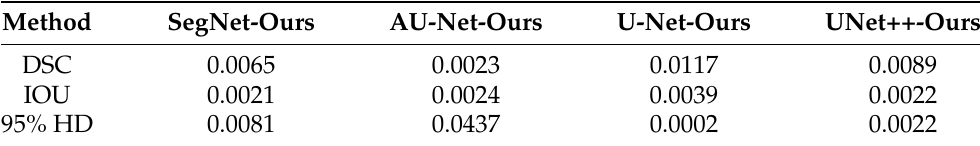
Figure 6. The box plots of metrics between Verte-Box and other algorithms. ( a ) DSC coefficient comparison; ( b ) IOU coefficient comparison; ( c ) 95% HD coefficient comparison. The central red lines indicate median values, green triangles the average values, boxes the interquartile range, whiskers the smallest and largest values, and data points (+) outliers. * indicates a significant difference between the corresponding experiments, with ** p ≤ 0.01, and * p ≤ 0.05 (paired t -test). Table 2. p value of different